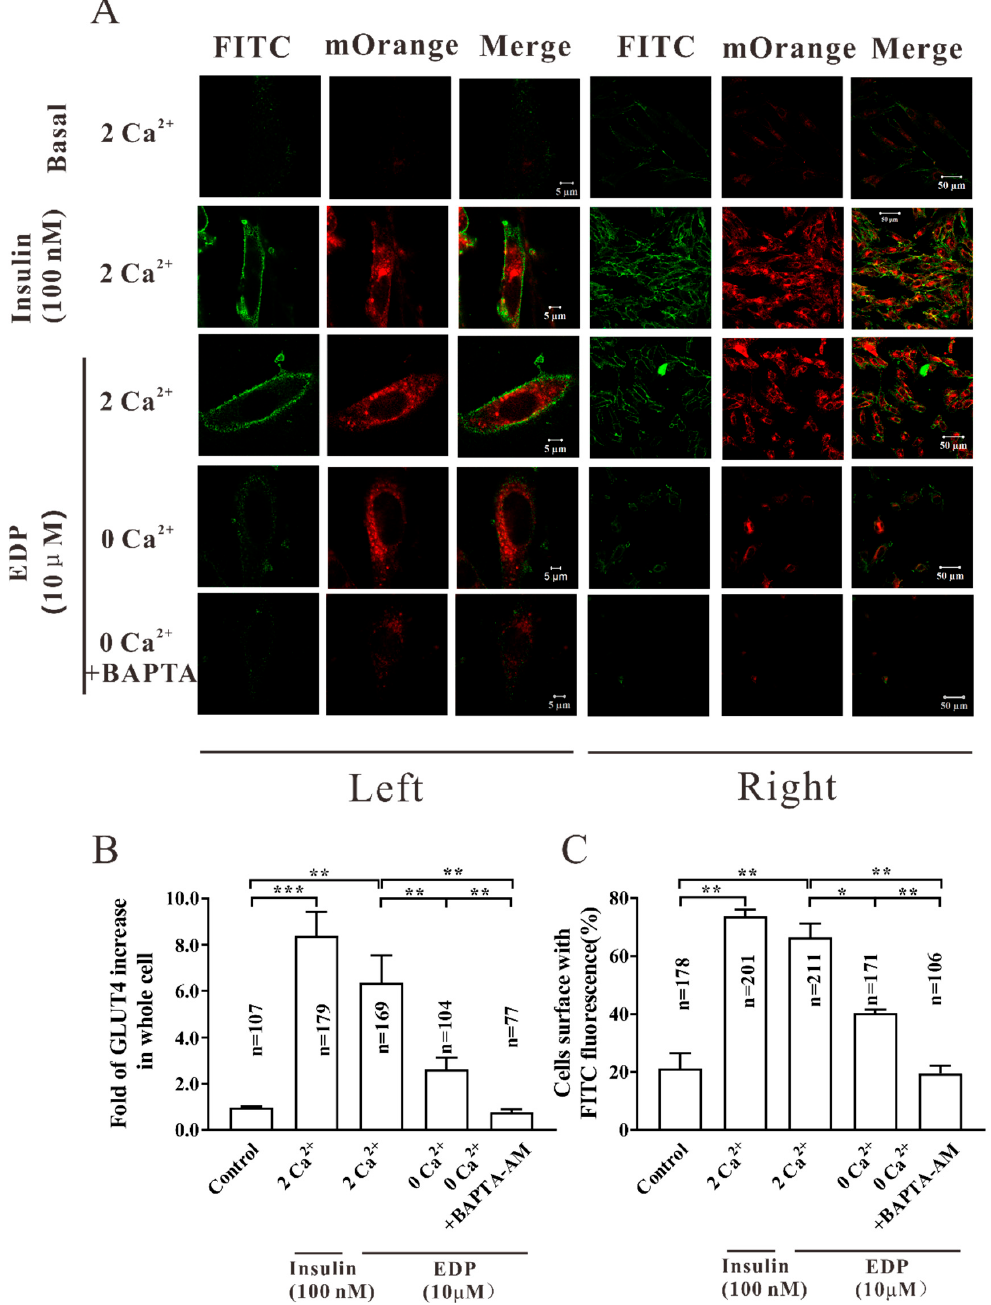
Figure 7. Ca 2+ is involved in EDP-induced GLUT4 expression and plasma membrane fusion. ( A ) Images of 10 uM EDP induced-GLUT4 fusion into plasma membrane under different concentrations of intracellular Ca 2+ level within 30 min. On the left is a single cell. Scale bar = 5 µ m. On the right is multicellular. Scale bar = 50 µ m. ( B ) Ca 2+ mediated EDP to promote GLUT4 expression in L6 cells within 30 min. ( C ) Activated FITC fluorescence cell count and quantitation in L6 cells within 30 min. The n value represents the number of GLUT4-mOrange cells in each group, data represent mean ± s.e.m. of values from three separate experiments with between 50 and 250 cells being examined in each experiment. * p < 0.05; ** p < 0.01; *** p <